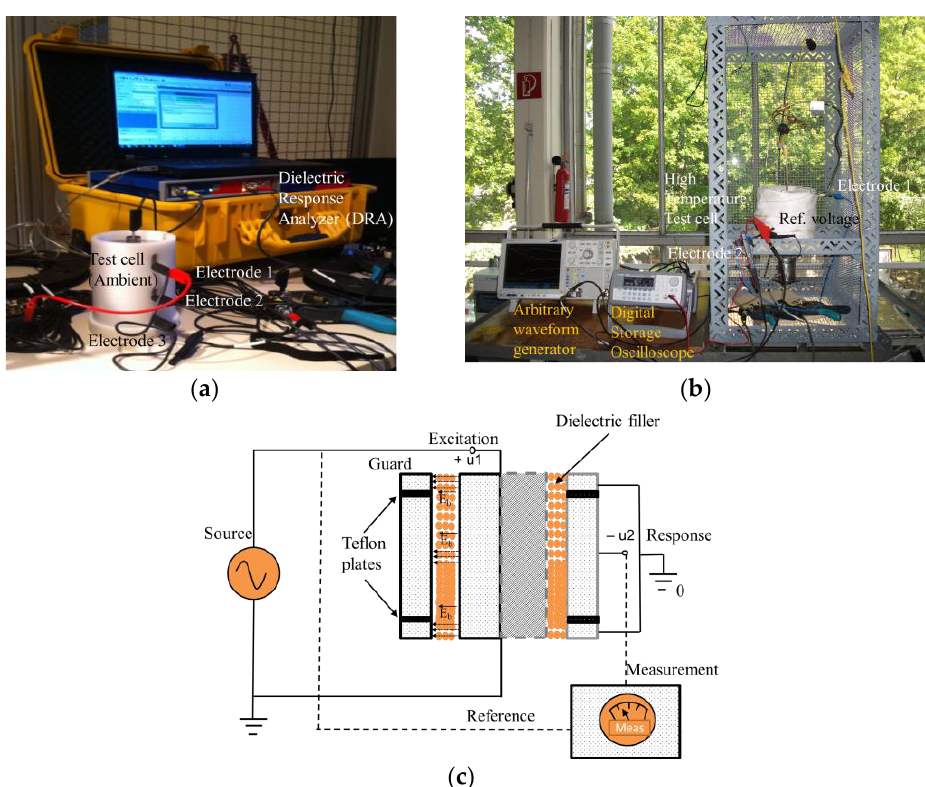
Figure 4. Setup used for measuring the frequency-dependent electrical properties of the DBD reactor bed materials. ( a ) Ambient temperature; ( b ) higher temperature; ( c ) common schematic diagram showing the underlying principle of performing a frequency response measurement.